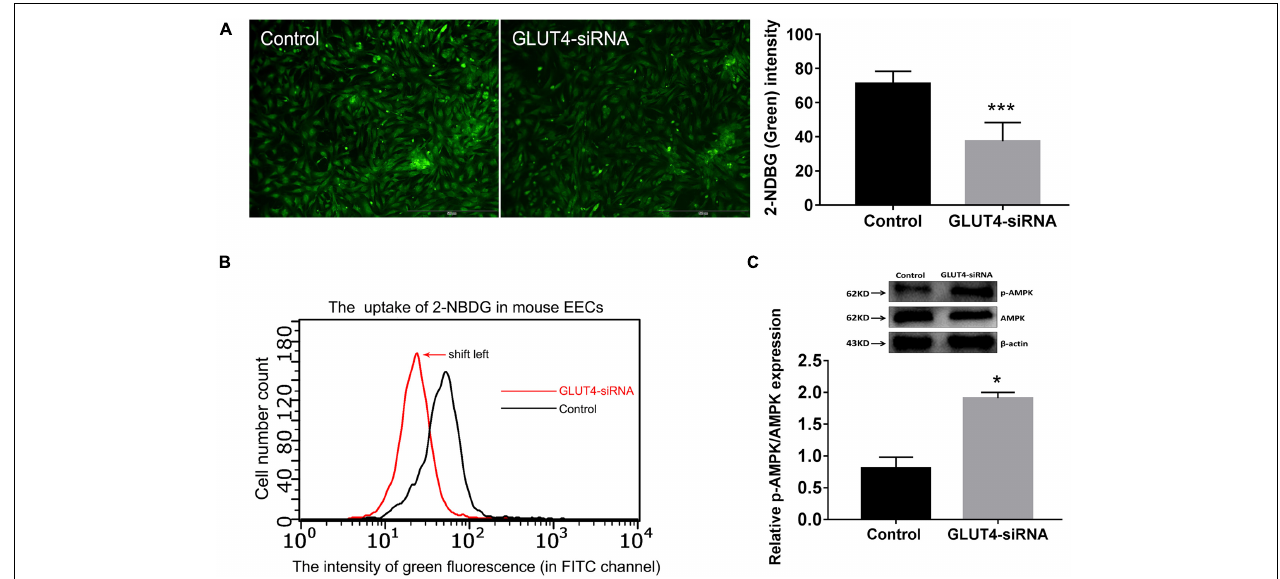
FIGURE 3 | Effect of GLUT4 on glucose uptake in mouse endometrial epithelial cells (EECs) following GLUT4-siRNA transfection. (A) The 2-NBDG ( green ) signals in mouse EECs shown by fluorescent scope. The cells in five visual fields per group were counted and photographed. The intensity of 2-NBDG in mouse EECs was analyzed by Image-Pro Plus 6.0 software. *** P < 0.001. Scale bar , 500 µ m. (B) The uptake of 2-NBDG in mouse EECs was detected by microcapillary flow cytometry (Millipore, United States) at the FITC channel. The abscissa is the fluorescence intensity and the ordinate is the cell number. The curve shift to the left indicated a dropped glucose uptake in mouse EECs. (C) The expressions of p-AMPK and AMPK in mouse EECs were detected by Western blotting. The ratio of p-AMPK/total AMPK reflects the state of intracellular energy demand in mouse EECs (the ratio increases as the intracellular energy demand increases). The relative densities of the p-AMPK and AMPK proteins were normalized by β -actin. * P < 0.05 vs. control. The experiment was performed at least three times.